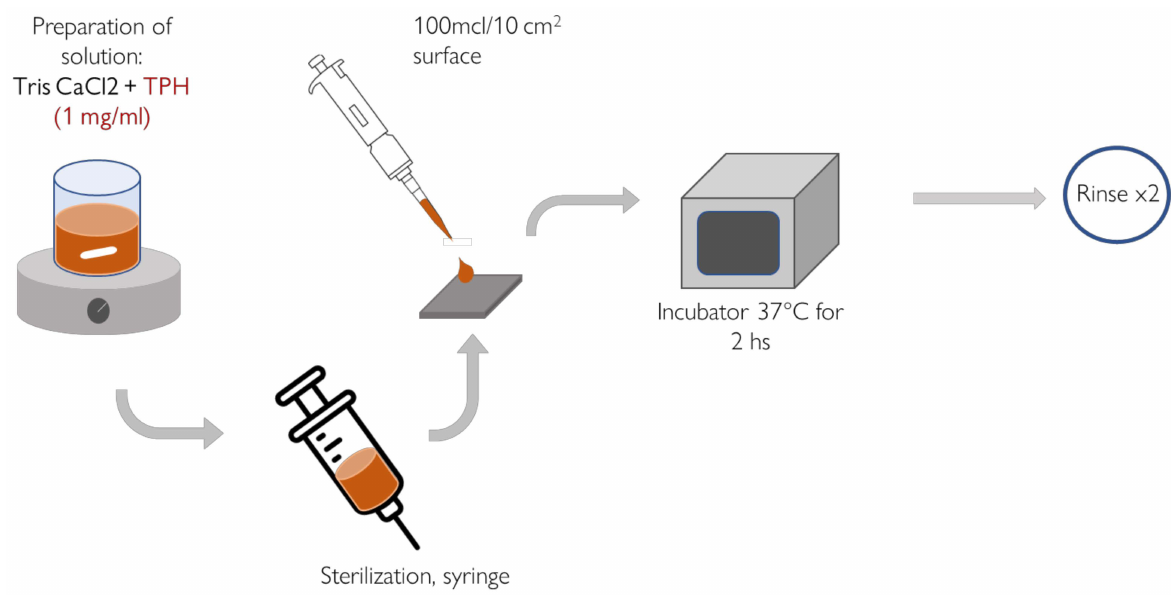
Figure 1. Method of functionalization with the TPH